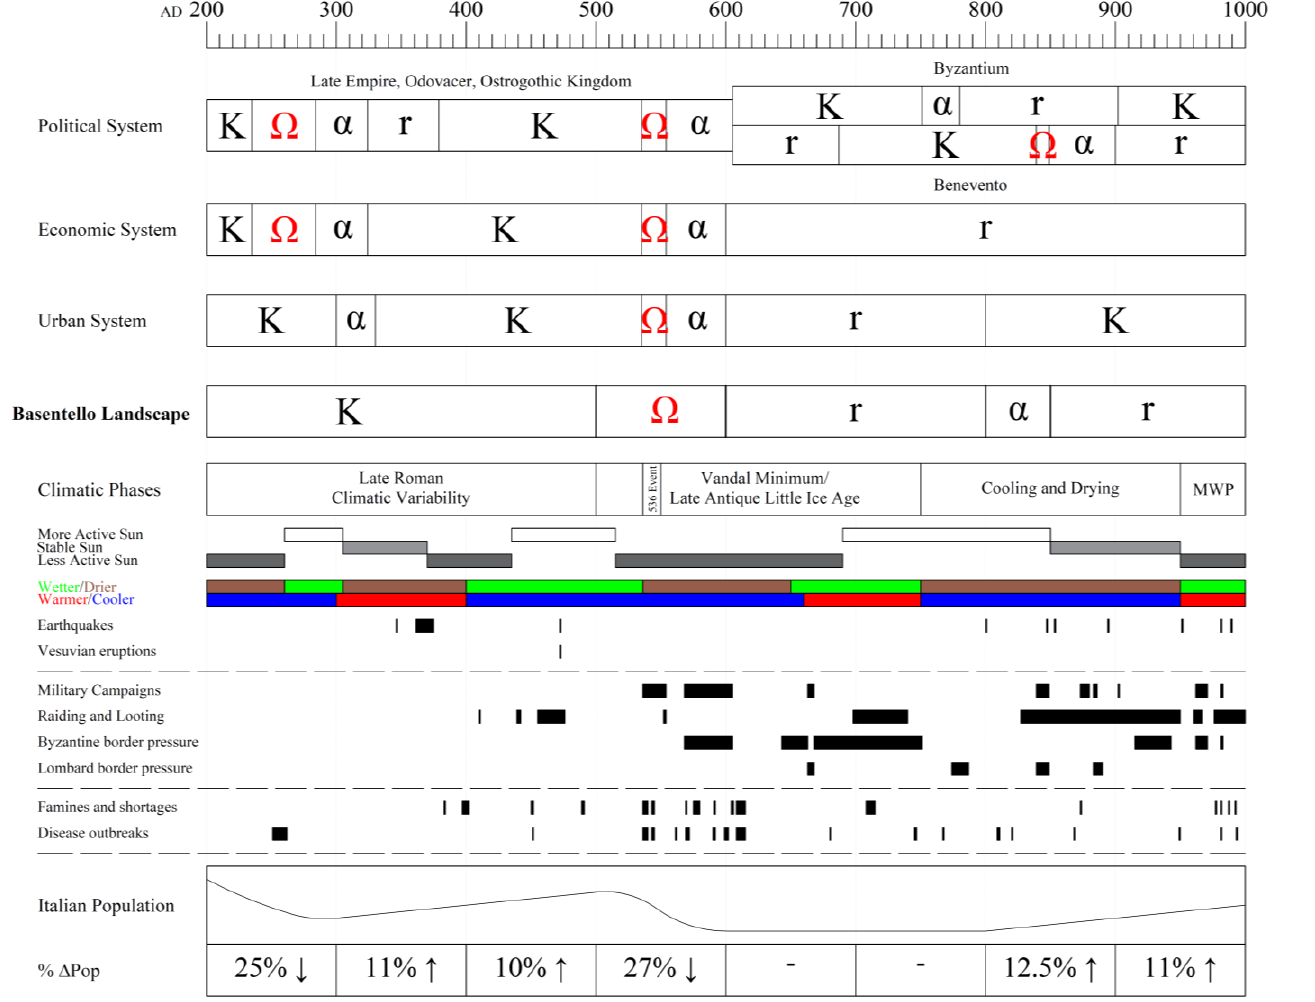
Figure 7. A panarchy for Southern Italy c. AD 200 to 1000.